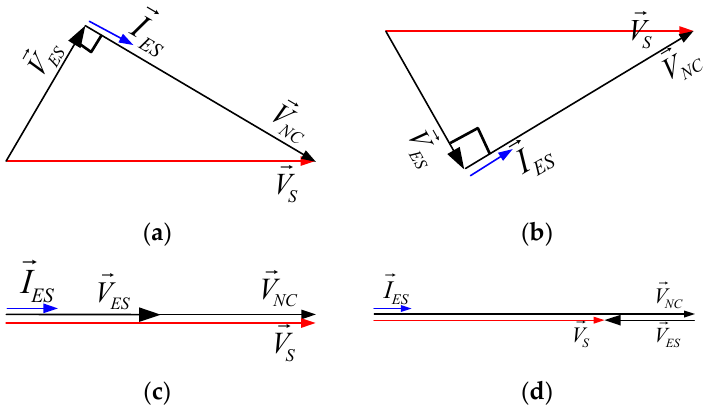
Figure 4. Vector diagrams under main types of compensation modes with pure resistive NCL. ( a ) Inductive; ( b ) Capacitive; ( c ) Positive real; ( d ) Negative real. Different compensation modes of ES-2 are determined by the phase angle between → V ES . For instance, in Figure 4a, I ES lags V ES by 90 ◦ , meaning that ES-2 operates at inductive mode.